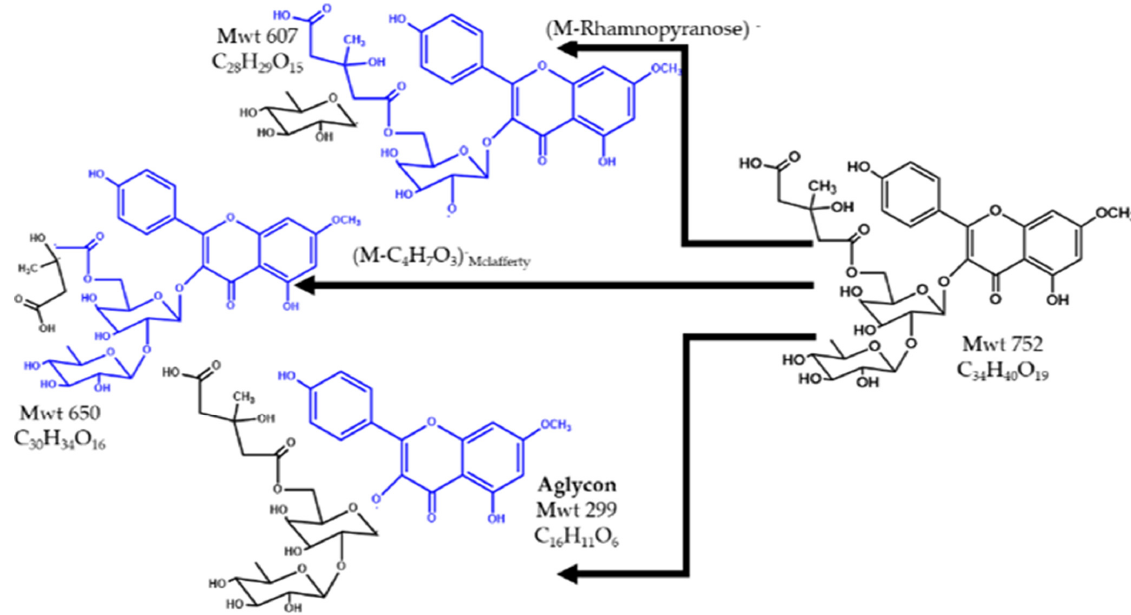
Figure 8. The structure and fragments of MethKaeHMG.